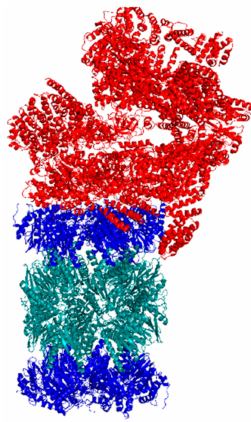
Figure 6. Cryo-EM structure of the human singly-capped 26S